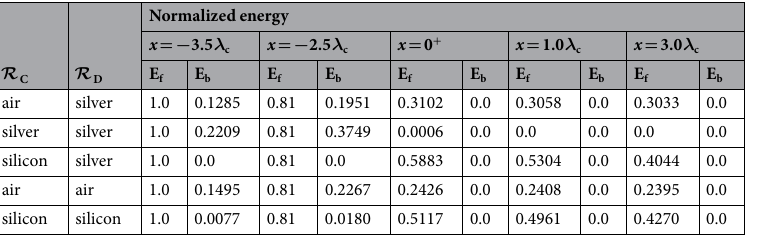
Table 1. Normalized energies of the forward signal (E f ) and backward signal (E b ) passing across the plane x =